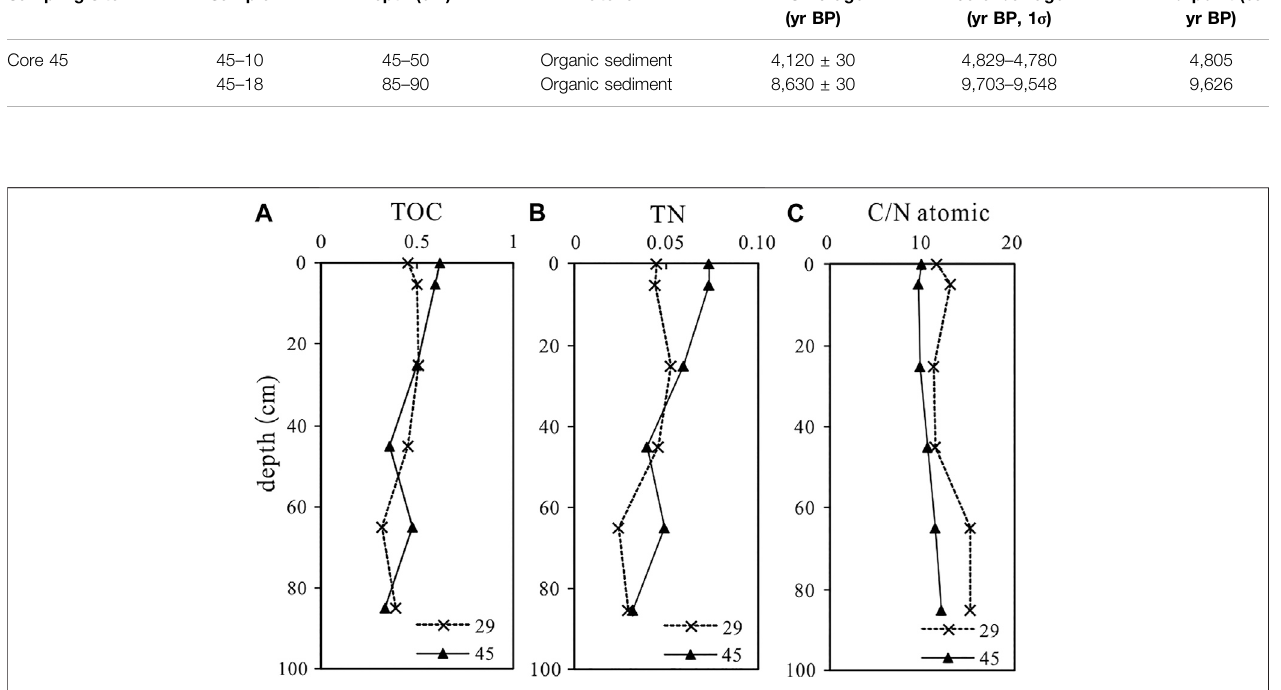
in Table 1 . The TOC content ranges of the samples of core 29 and core 45 were 0.32 – 0.51% and 0.33 – 0.62%, respectively. The mean TOC in core 29 and core 45 samples are 0.44% and 0.48%, respectively. The TN values of core 29 and core 45 varied from